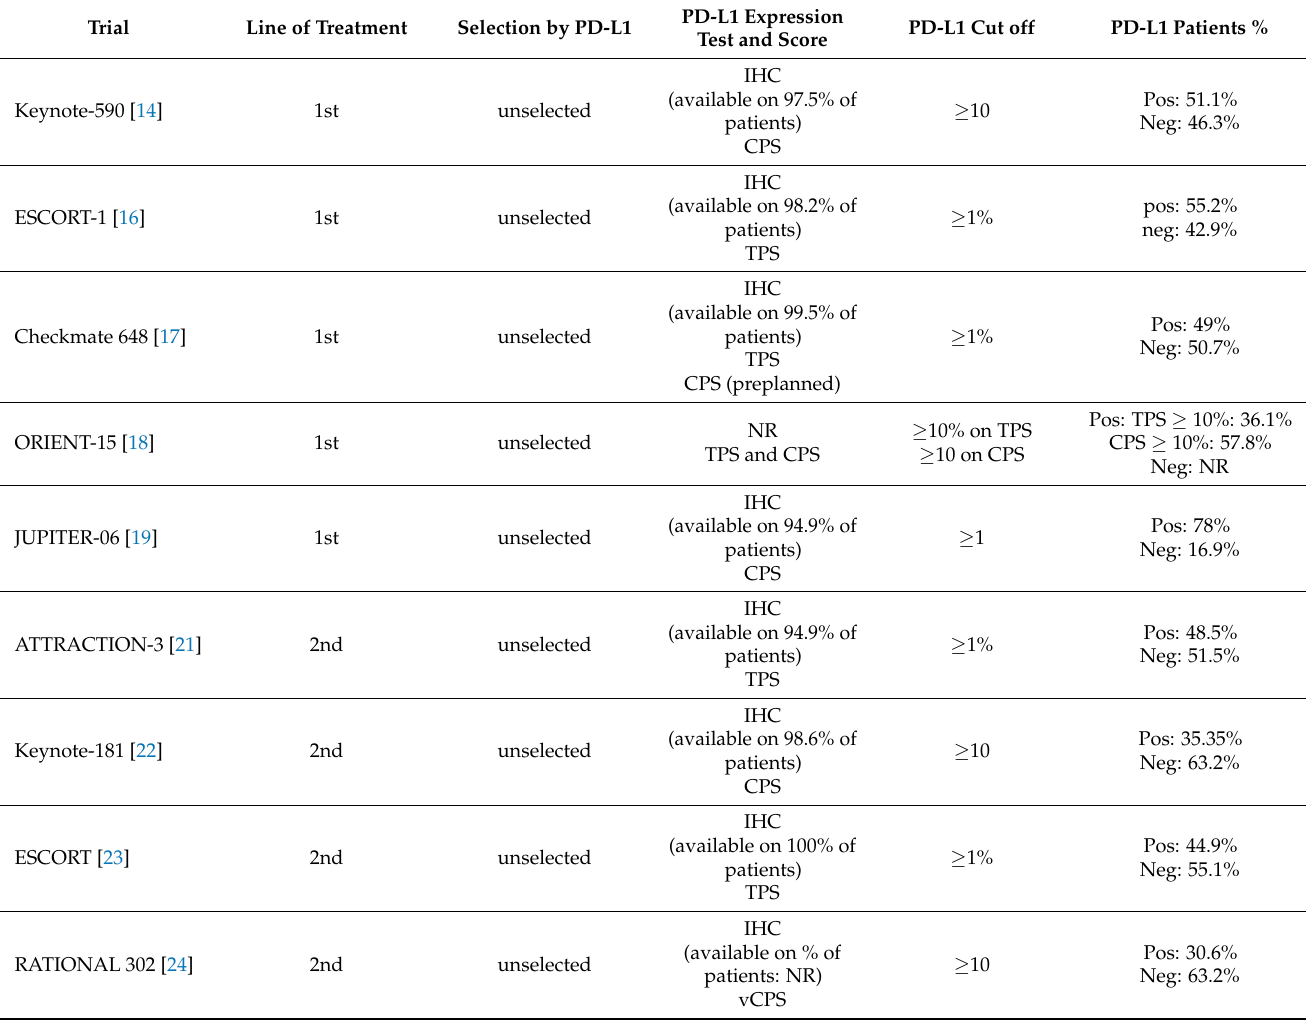
Table 4. PD-L1 assessment and expression in oesophageal squamous cell carcinoma treated within landmark immunotherapy